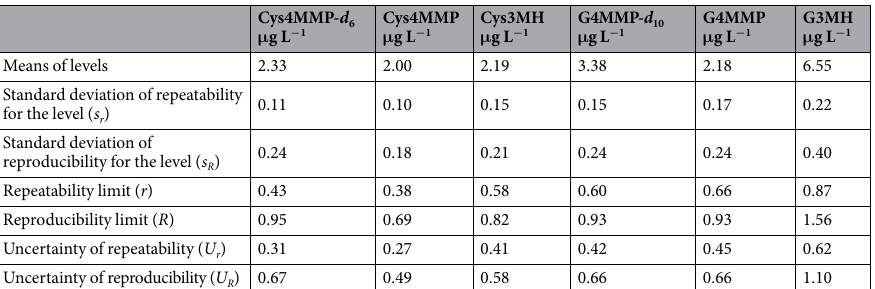
Table 2. Standard deviations of repeatability and reproducibility for thiol precursors with the use of purification/concentration